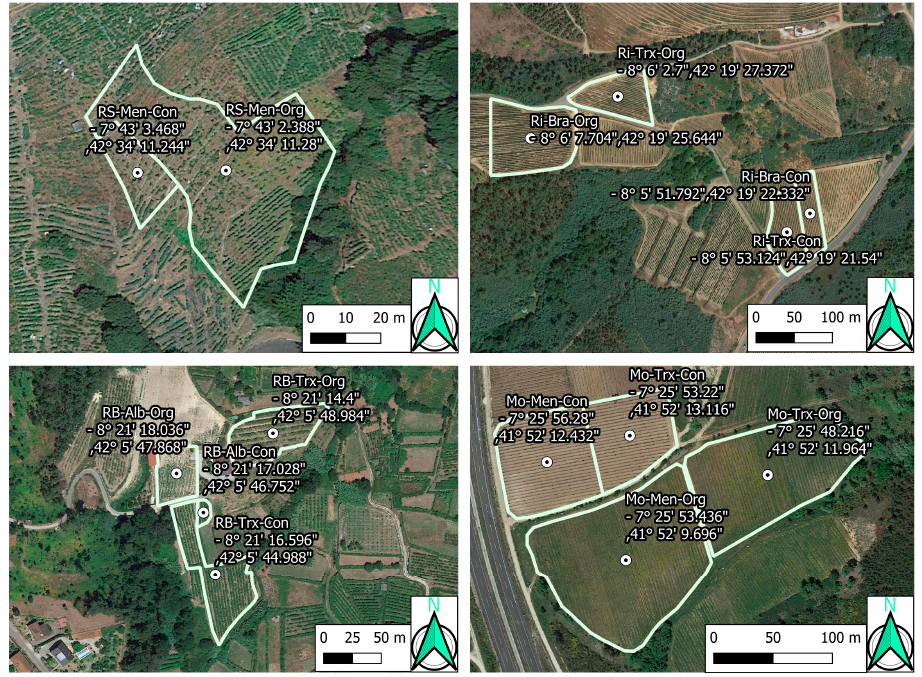
Figure 2. Vineyard locations and coordinates (WGS84). Designations of Origin (DOs: Monterrei, Mo; R í as Baixas, RB; Ribeira Sacra, RS; Ribeiro, Ri); culture system (Organic, Org; Conventional, Con); grapevine varieties (Albariño, Alb; Brancellao, Bra; Menc í a, Men; Treixadura,